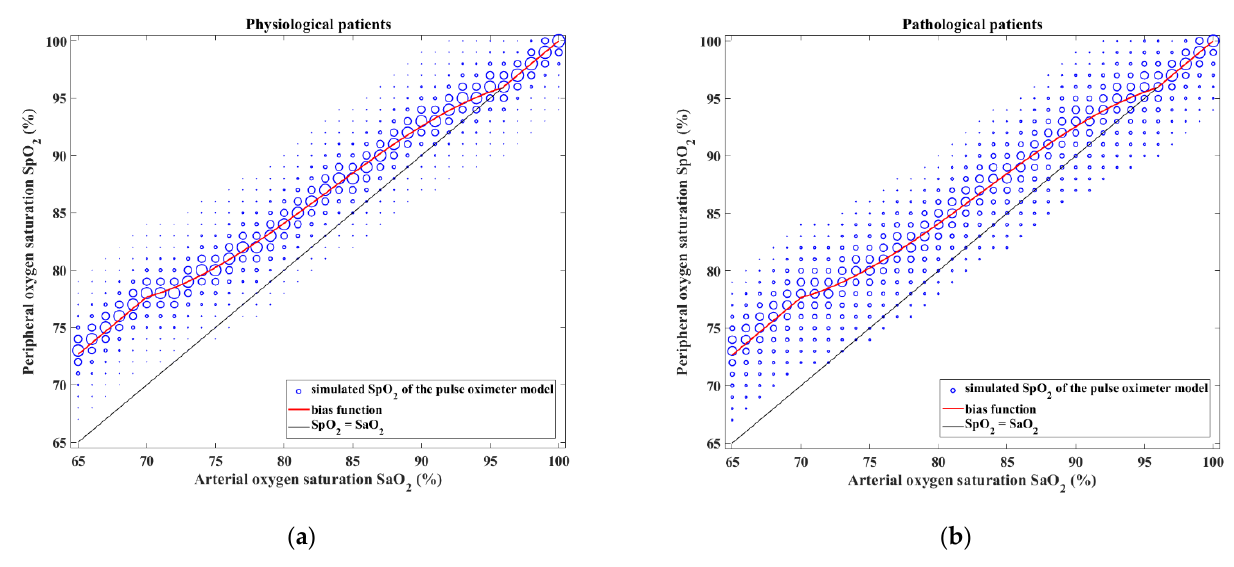
Figure 10. The output of the pulse oximeter model consisting of SaO 2 –SpO 2 bias and SpO 2 measure- ment noise for ( a ) physiological and ( b ) pathological patients. Each SaO 2 value is converted to an SpO 2 value to which noise is added according to the properties shown in Figures 8 and 9. The size of the symbol of each SaO 2 –SpO 2 pair is proportional to the frequency of its occurrence.